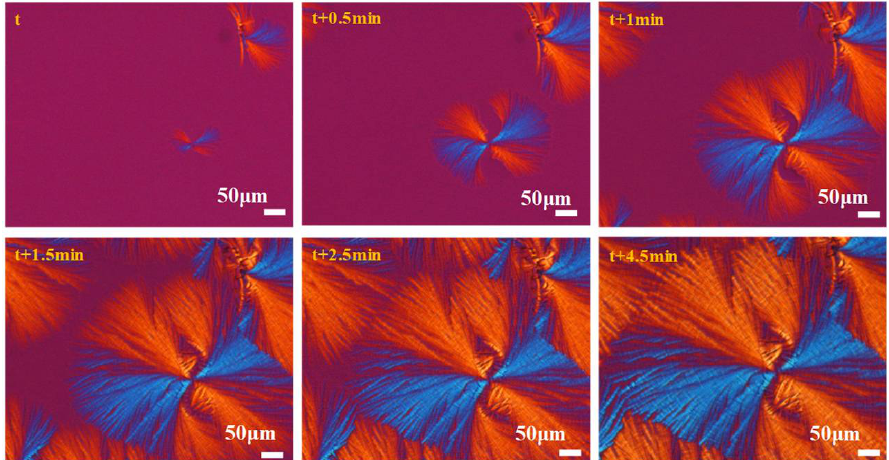
Figure 4. In situ evolution of MA morphology (from R-MA/PVPh (50/50)) upon solvent-evaporation crystallization at 60 °C, from t to t + 4.5 min, where t = initiation of first trace of nuclei.